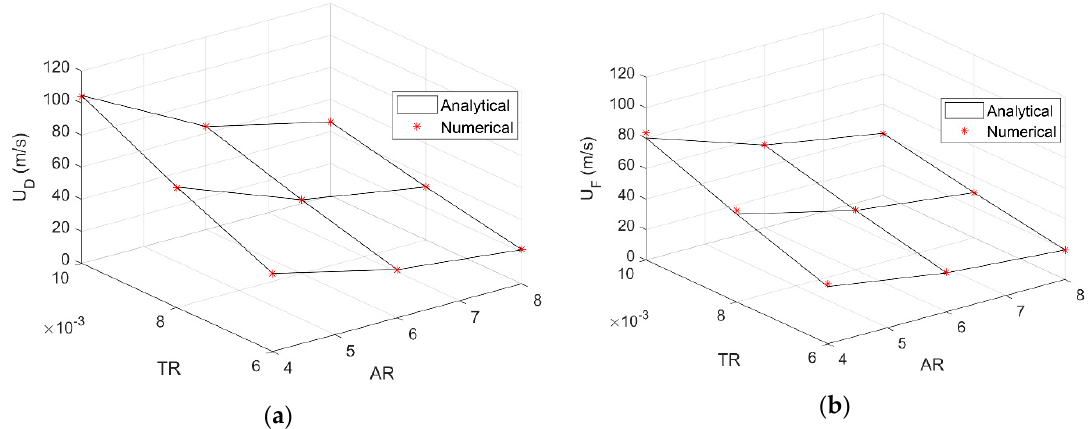
Figure 9. Divergence ( a ) and flutter ( b ) speeds according to MST and DLM.